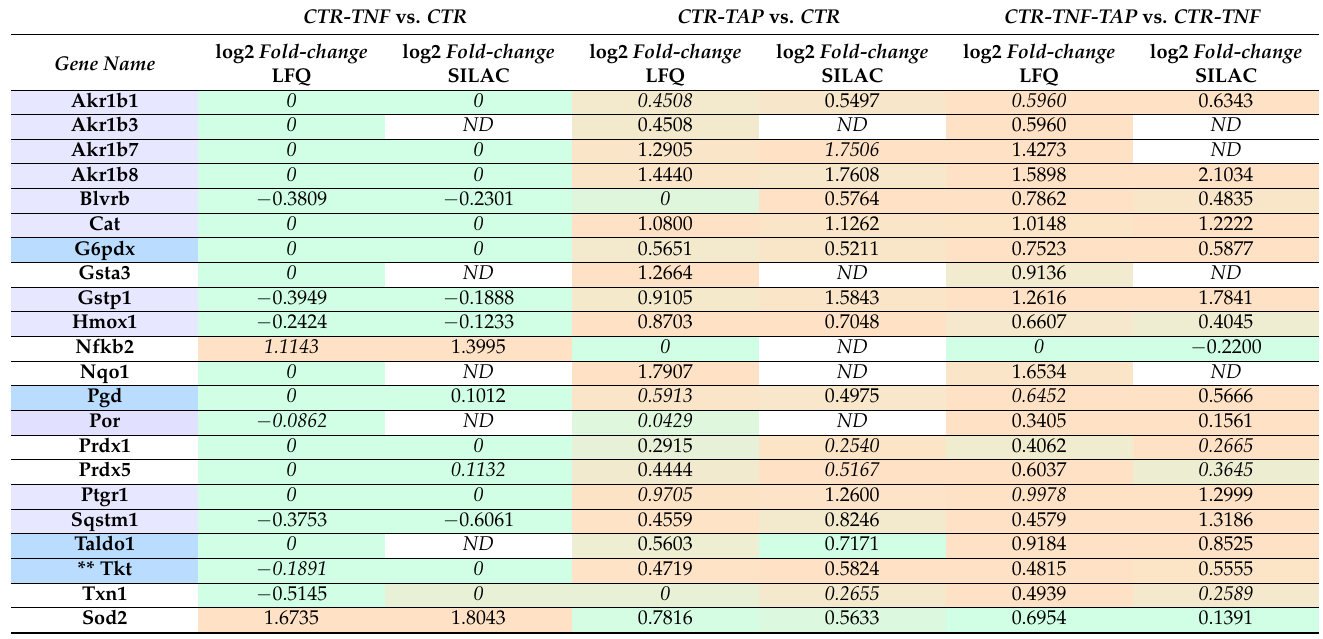
Table 2. Key proteins identified by quantitative proteomics analysis; fold-change values calculated by each of the experimental approaches used are reported by gene product. The fold-change values are classified according to the comparative analysis of the conditions tested. ND indicates a not- detected protein identification with the corresponding proteomic approach. The value 0 indicates a fold-change not significantly different from zero. Each fold-change set, reported per gene product and per proteomic approach, is colored on a green (minimum value) to light orange (maximum value) color scale according to the conditional formatting function of excel. The gene products involved in the nuclear factor erythroid-derived 2 signaling pathway are highlighted in light violet and those involved in the pentose phosphate pathway in light